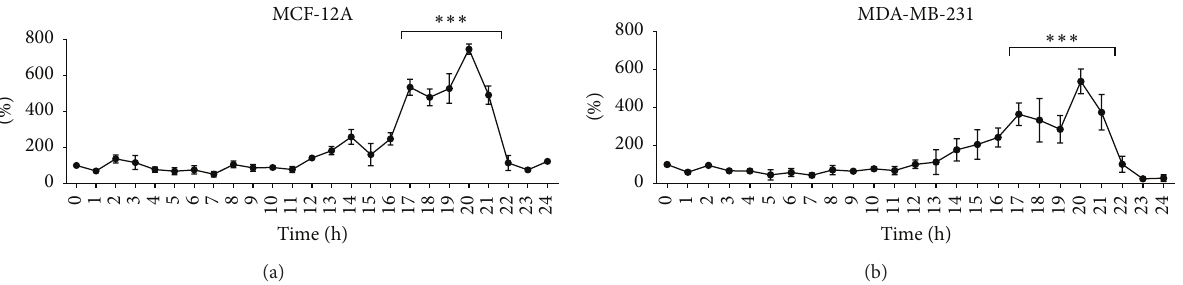
Figure 1: Rhythmic expression of the mammalian circadian protein period 2 (Per2) in nontumourigenic breast epithelial MCF-12A cells (a) and MDA-MB-231 estrogen receptor negative human breast adenocarcinoma cells (b). MCF-12A and MDA-MB-231 cells were harvested hourly for a period of 25 hours (Time 0 = baseline). Western blot analysis was employed to assess relative Per2 protein levels. Values (normalized to GAPDH) are expressed as a percentage of baseline and presented as mean ± SEM ( 𝑛 = 3 ). ∗ ∗ ∗ = 𝑃 < 0.0001 versus